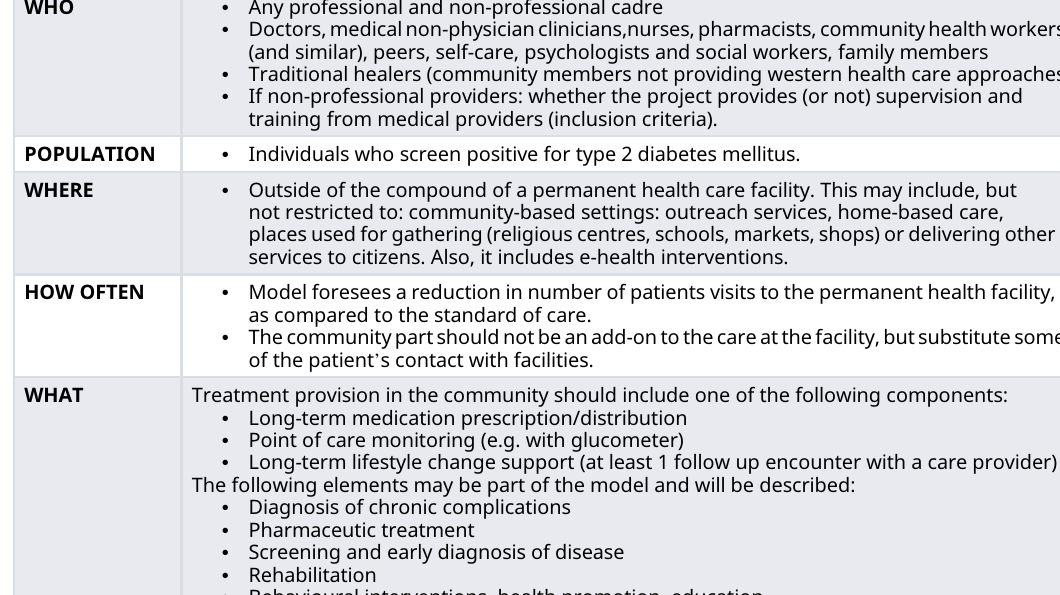
Table 2. Components of a community-based model of care. WHO (cid:129) Any professional and non-professional cadre (cid:129) Doctors,medicalnon-physicianclinicians,nurses,pharmacists,communityhealthworkers (and similar), peers, self-care, psychologists and social workers, family members (cid:129) Traditional healers (community members not providing western health care approaches (cid:129) If non-professional providers: whether the project provides (or not) supervision and training from medical providers (inclusion criteria). POPULATION (cid:129) Individuals who screen positive for type 2 diabetes mellitus. WHERE